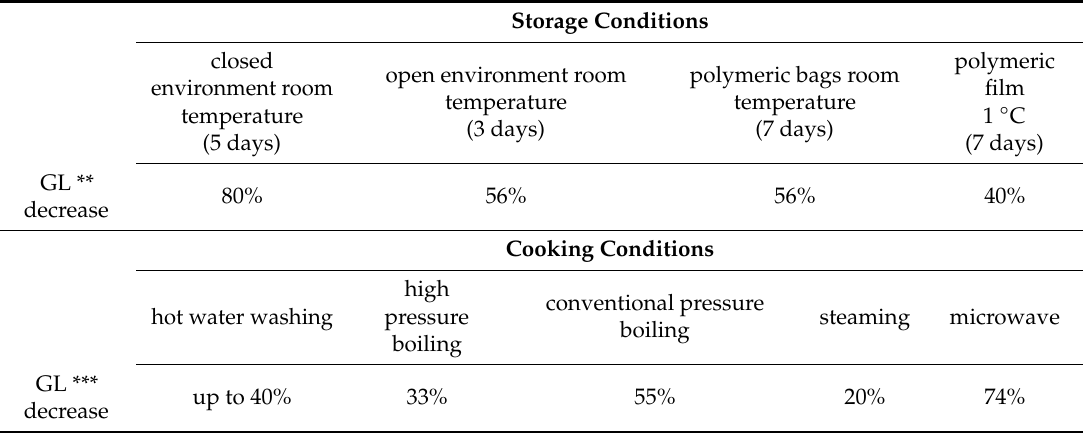
Table 2. Factors influencing GL content. Storage conditions and cooking are the main factors involved in the loss of GLs. Here are the reported cases of broccoli; however, di ff erent species of Brassicaceae are a ff ected in di ff erent modes with respect to broccoli